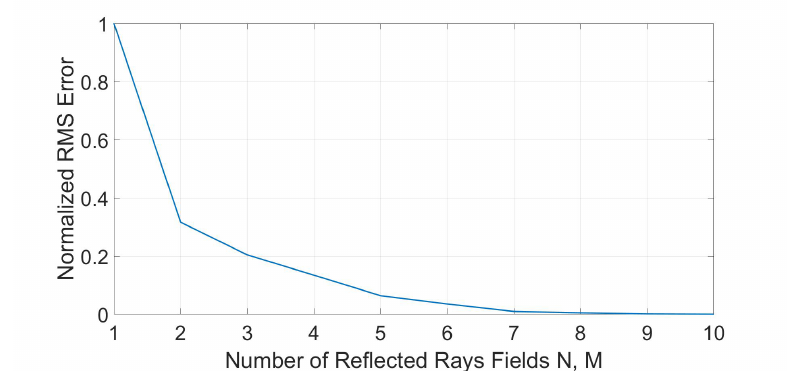
Figure 9. Normalized RMSE at 28 GHz inside the first 140m of Lincoln Tunnel, using a directive horn